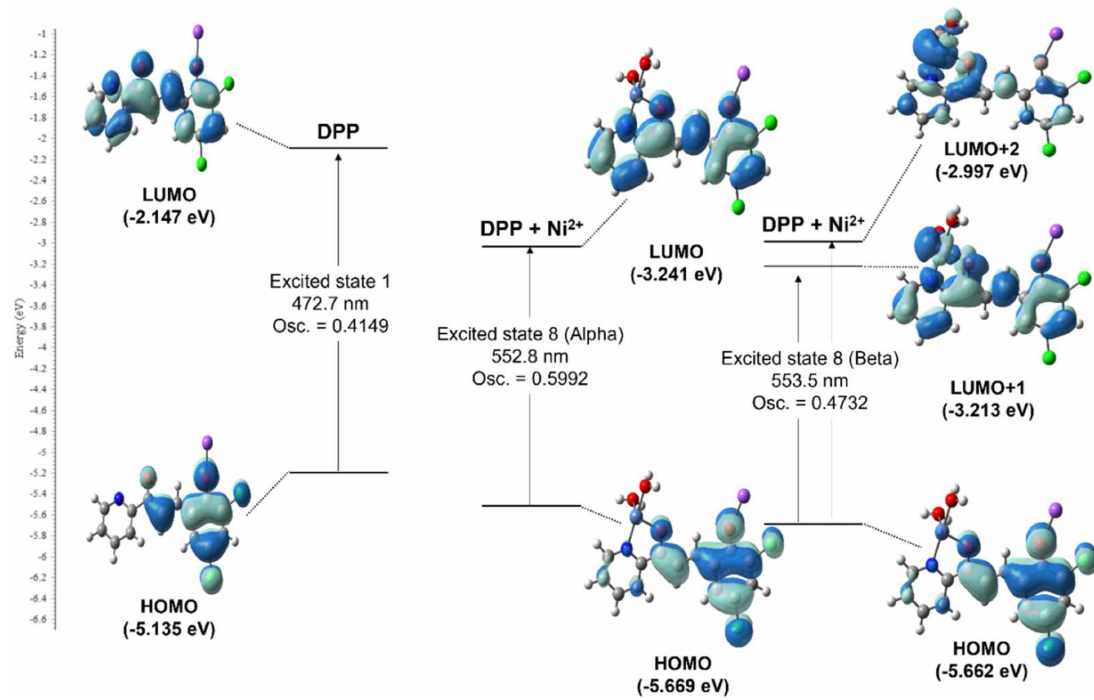
Figure 12. MO diagrams and excitation energies of DPP and DPP -Ni 2+